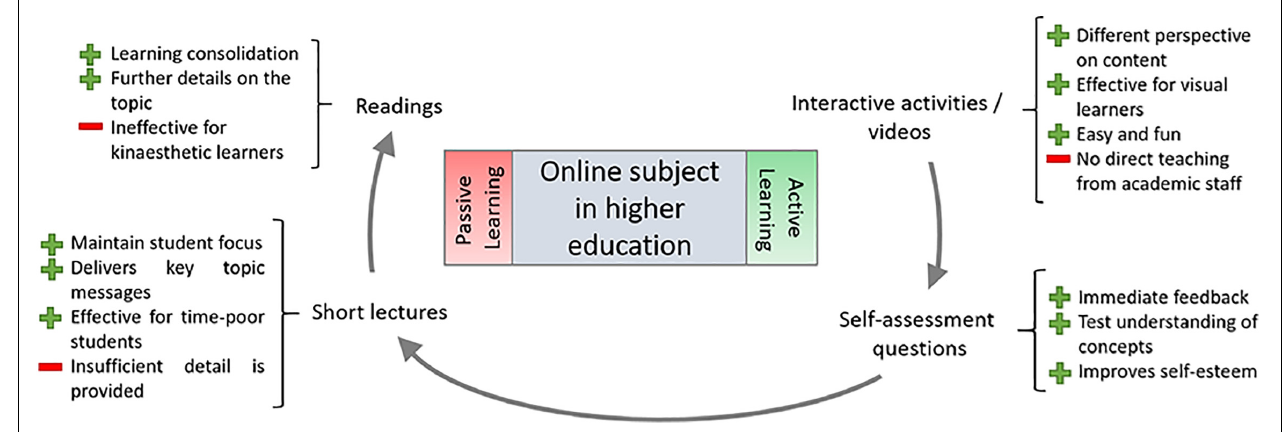
FIGURE 1 | Summary of findings. Advantages and disadvantages of learning activities in an online higher education